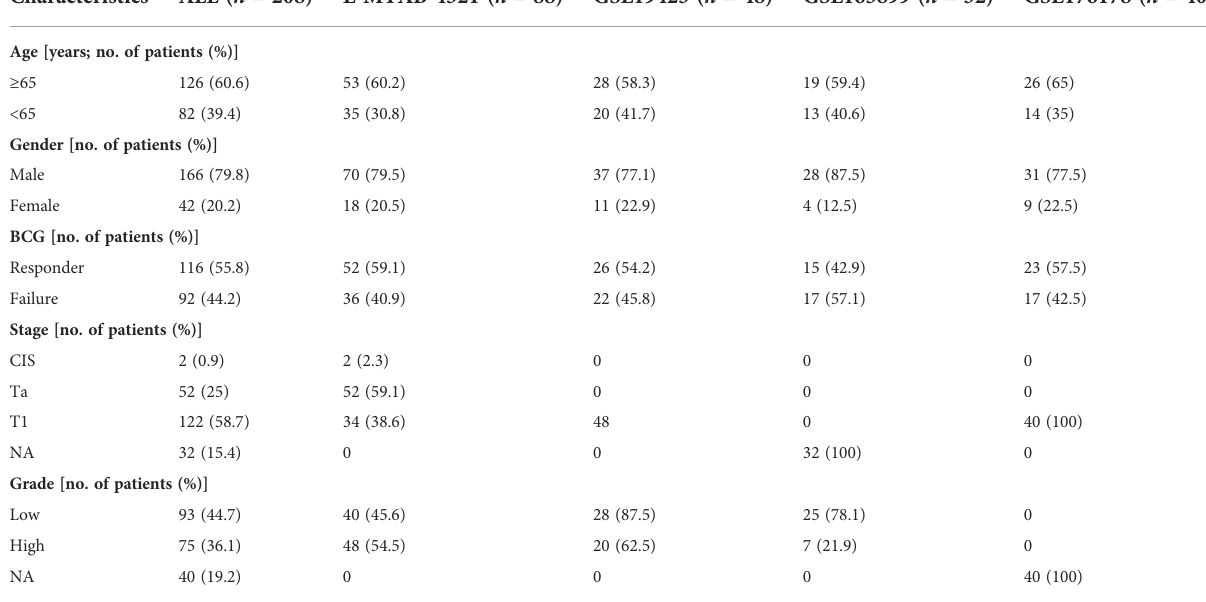
TABLE 1 Clinical information of bladder cancer patients in BCG cohort.